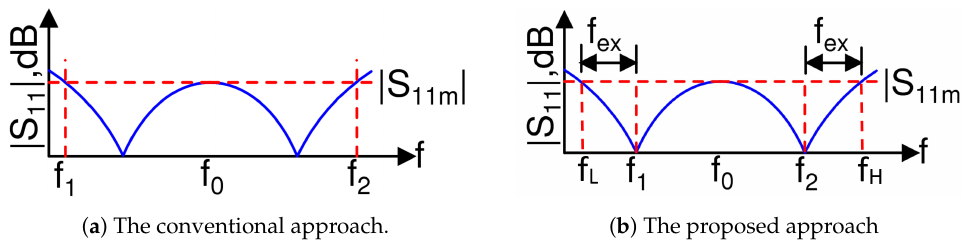
Figure 1. The conventional vs. the proposed design methodologies.